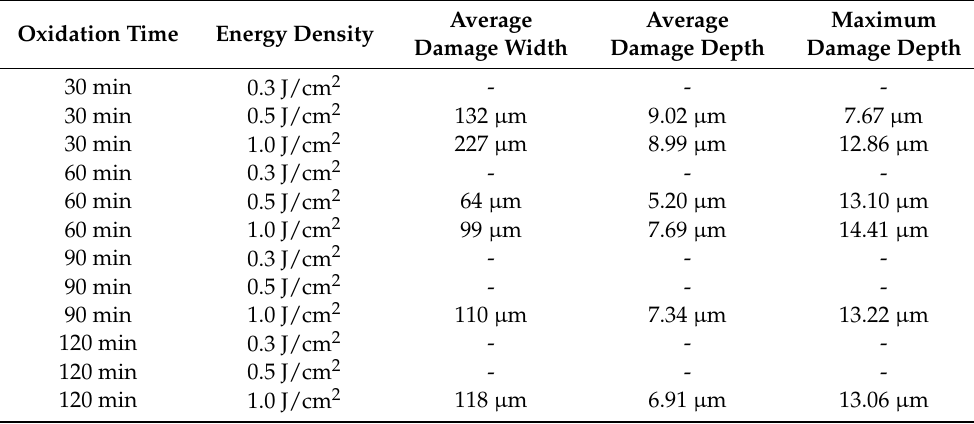
Table 9. Width and depth of laser damage pit of oxidation time group.